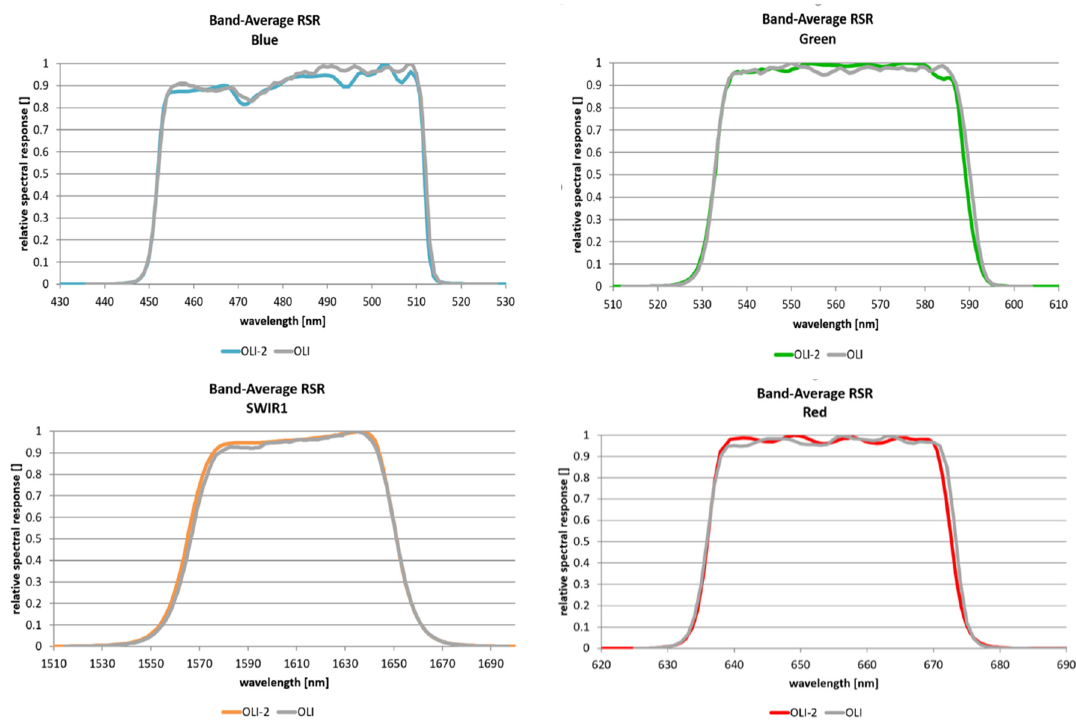
Figure 1. Representative relative spectral response (RSR) functions for OLI and OLI-2. These are band averages of 14 focal plane modules (FPMs) showing small differences.